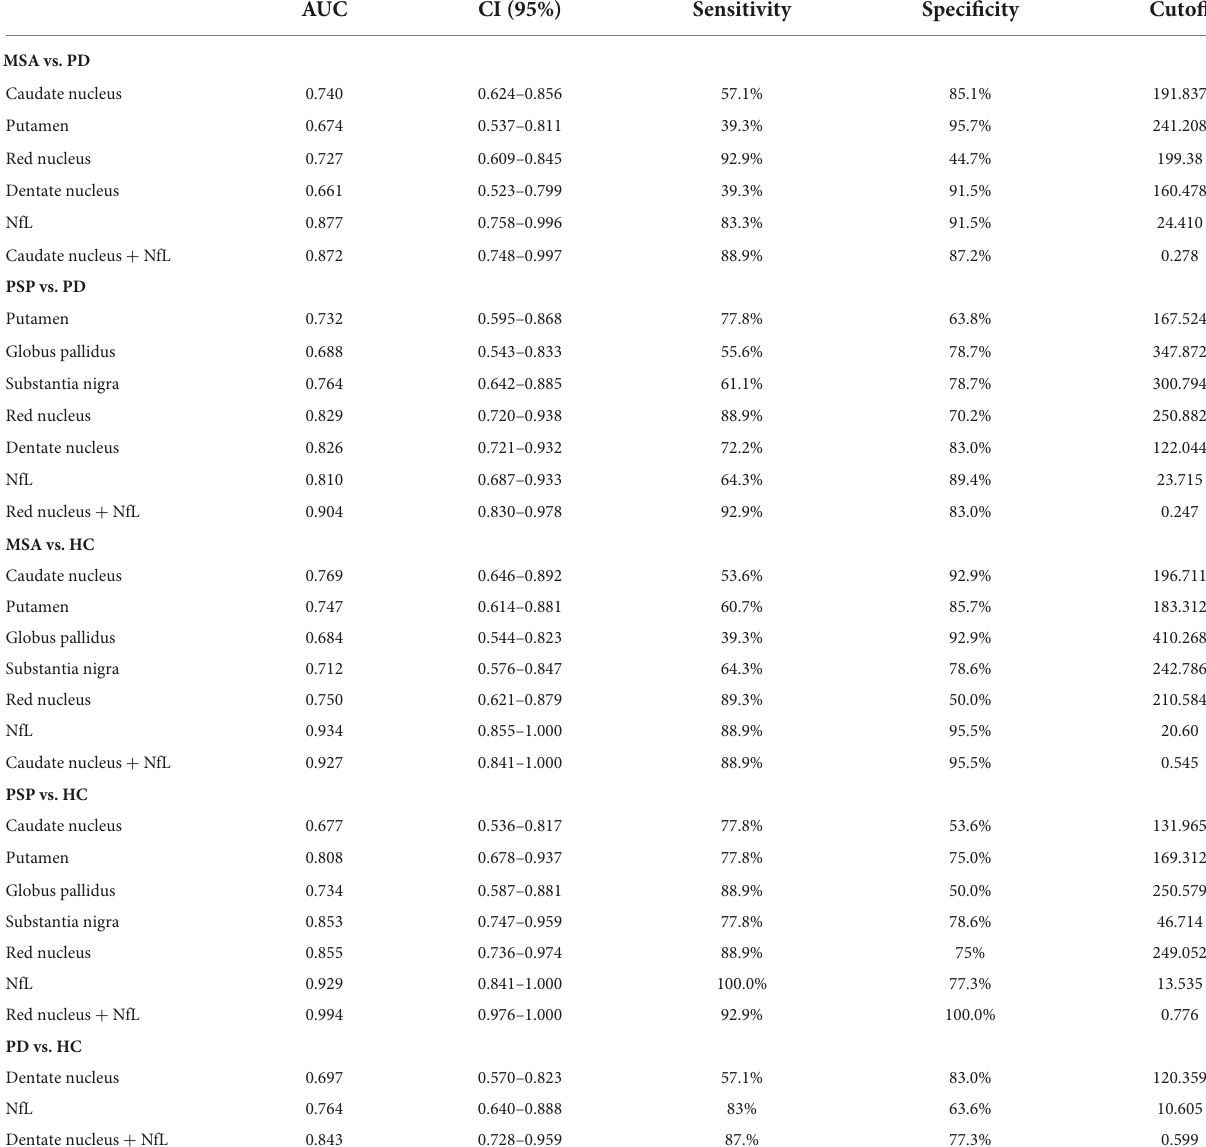
TABLE 3 Significant differences of diagnostic accuracy in the comparison with HC, PD, MSA, and PSP. AUC CI (95%) Sensitivity Specificity